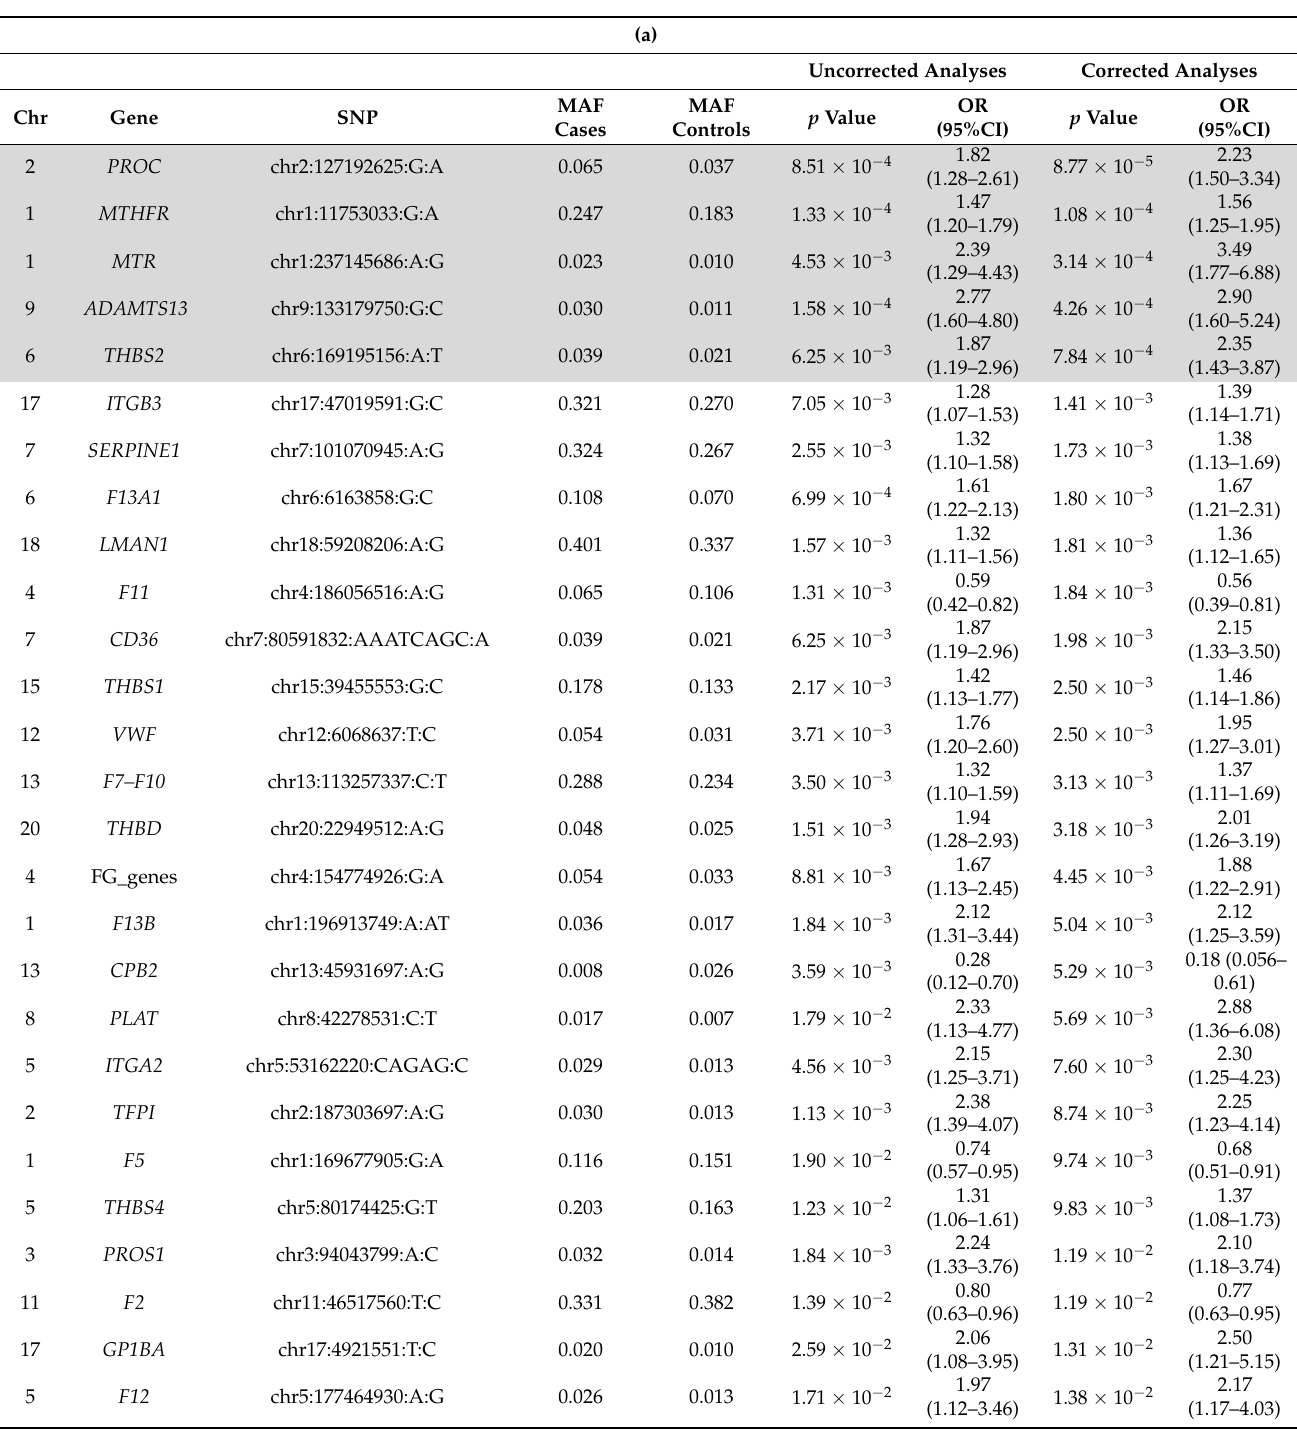
Table 2. (a) Top association results in selected autosomal genes; (b) Top association results in selected X-chromosome genes.